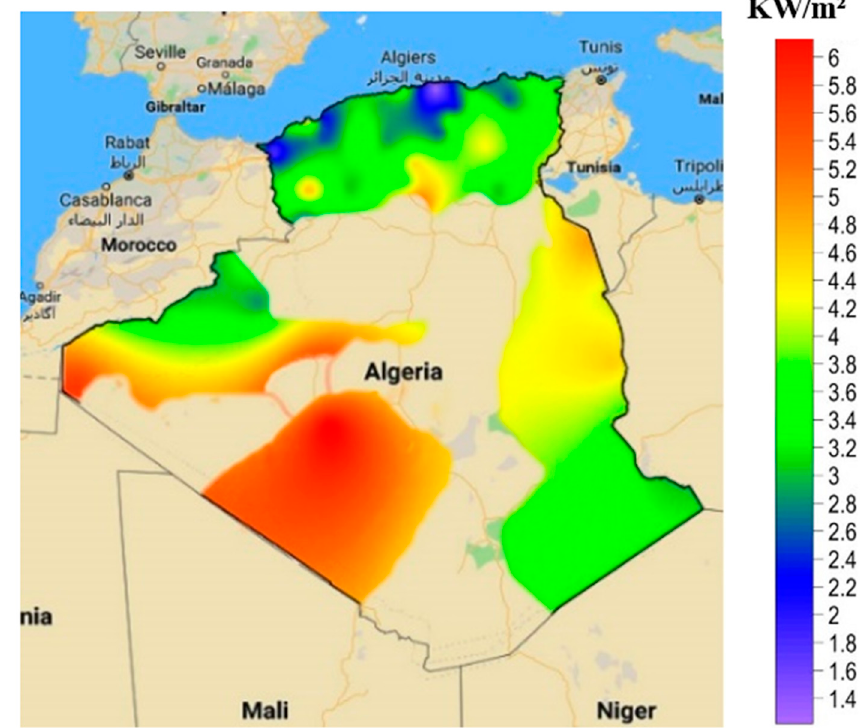
Figure 7. The solar irradiation in Algeria kW/m 2 .